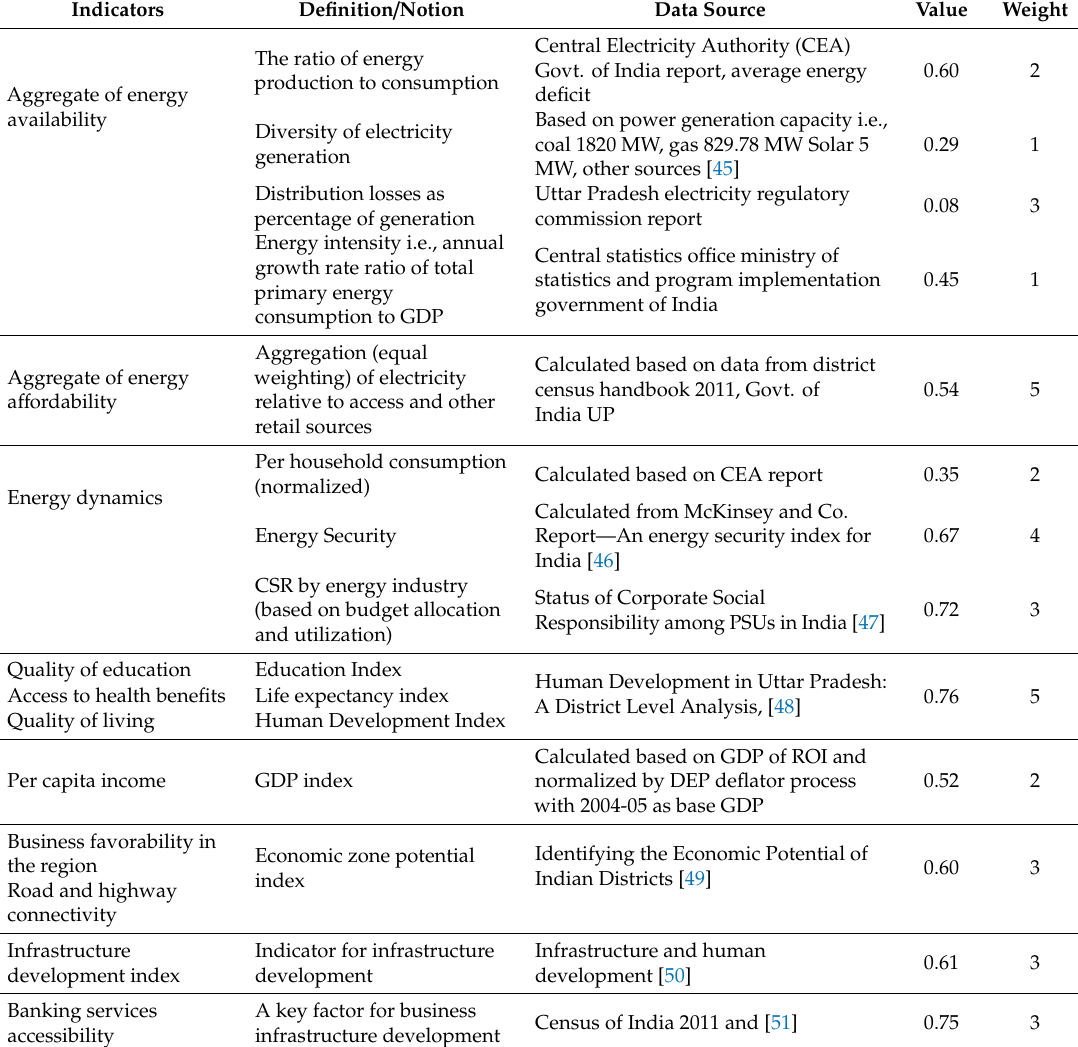
Table 2. Indicators for energy, population, urban development